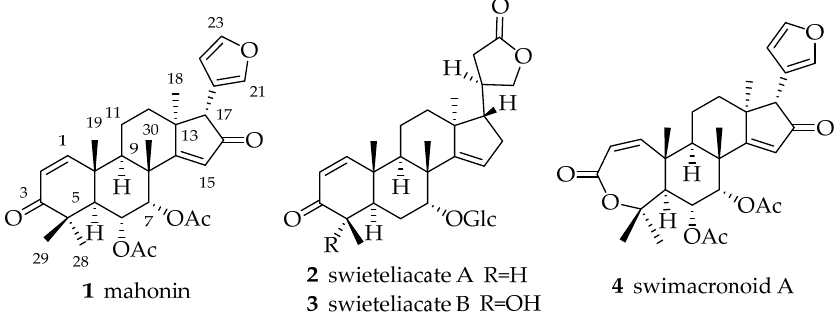
Figure 1. Chemical structures of azadirone ‐ type and evodulon ‐ type limonoids 1 – 4 .